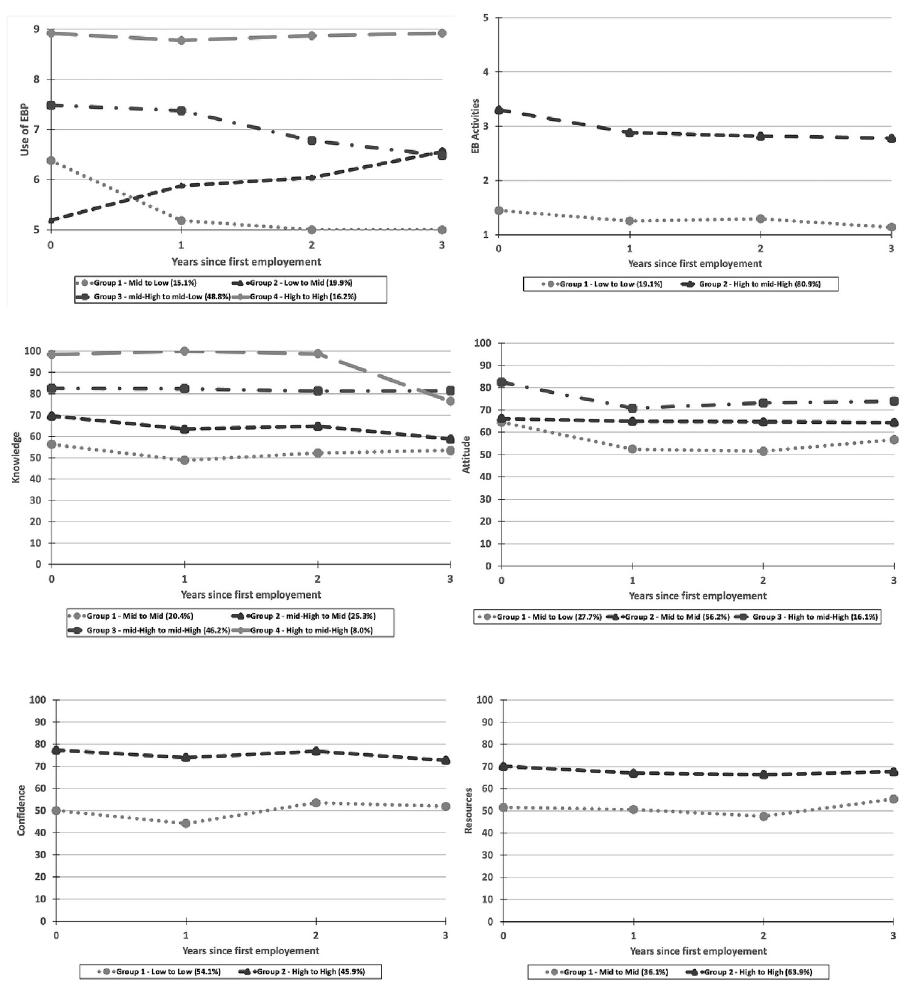
Fig 1. Over the time change in group trajectories of OTs and PTs in all six EBP constructs from the time of first employment.